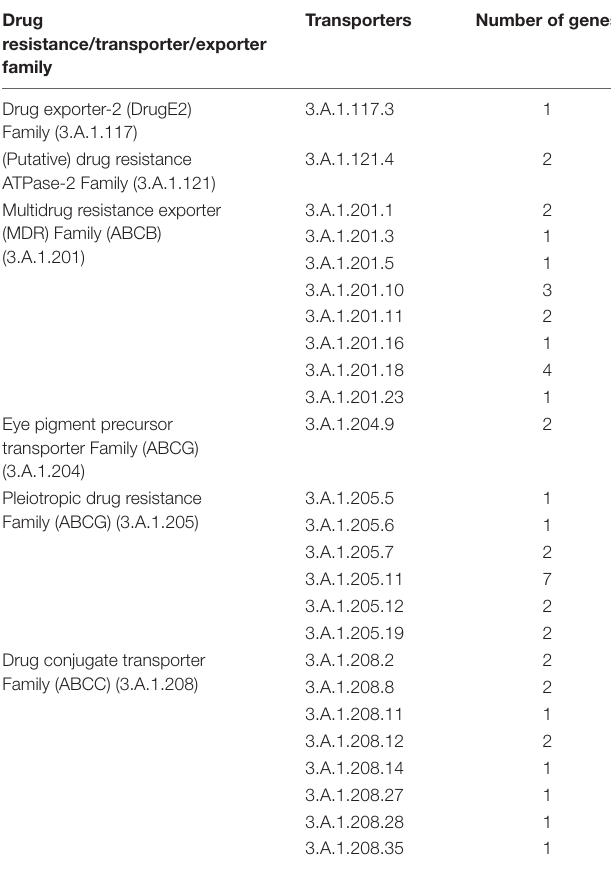
Transporters Number of